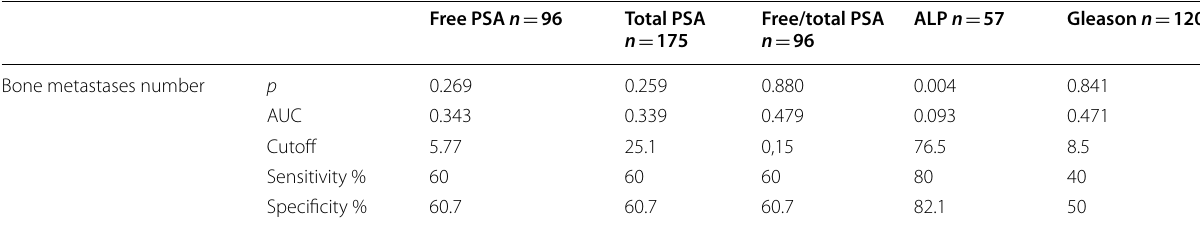
Table 3 Sensitivity and specificity percentage of ALP, free PSA, total PSA, Gleason score, and free/total PSA